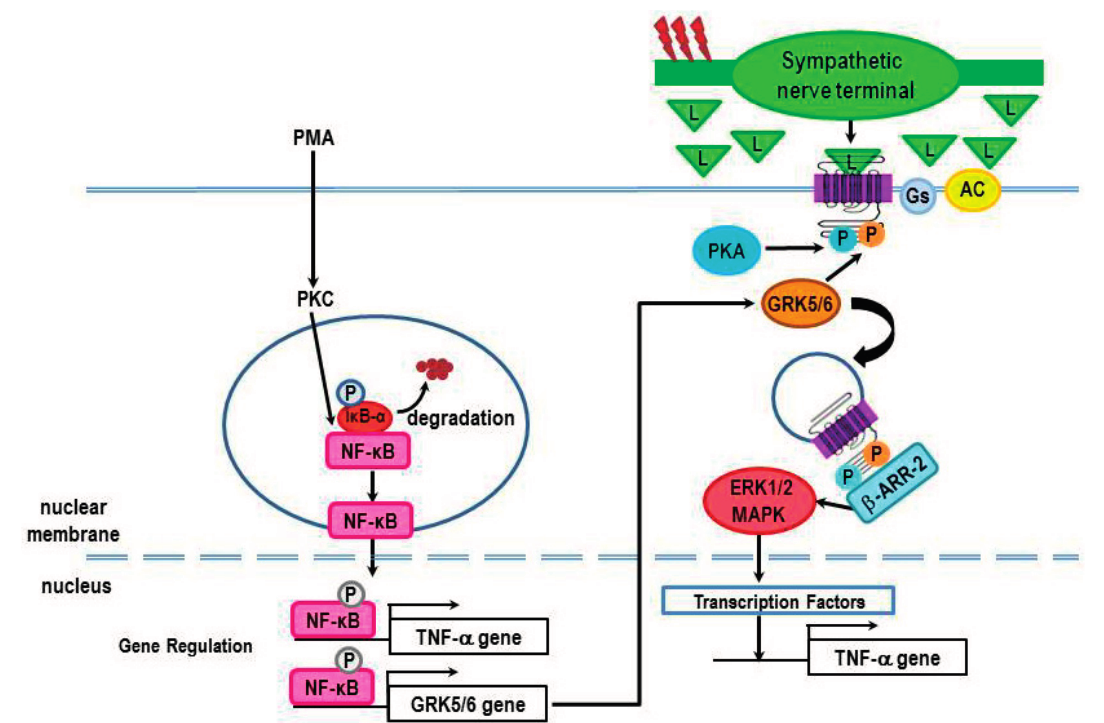
Figure 8. The presence of a β 2 -AR ligand during lipopolysaccharide (LPS) or phorbol 12-myristate 13-acetate (PMA)-induced macrophage activation causes reduced or increased production of TNF- α , IL-12 and nitric oxide respectively. The β 2 -AR-induced immunosuppression in LPS-treated macrophages is consistent with the activation of adenylyl cyclase (AC), and subsequently PKA. LPS promotes adenylyl cyclase